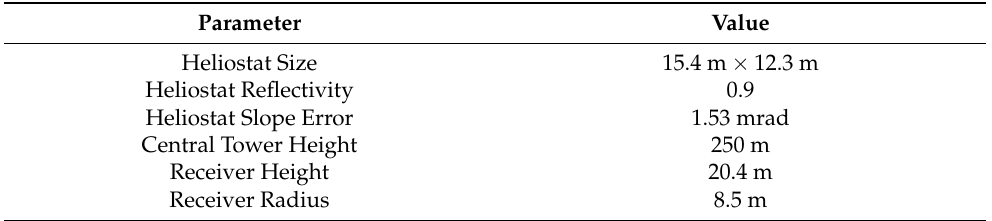
Table 1. Parameters of the heliostat and the receiver